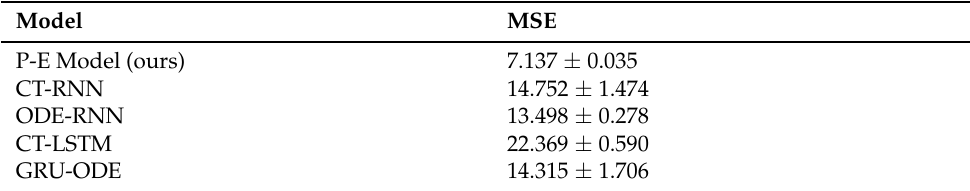
Table 3. Prediction of MMSE scores. (mean ± standard deviation, N =